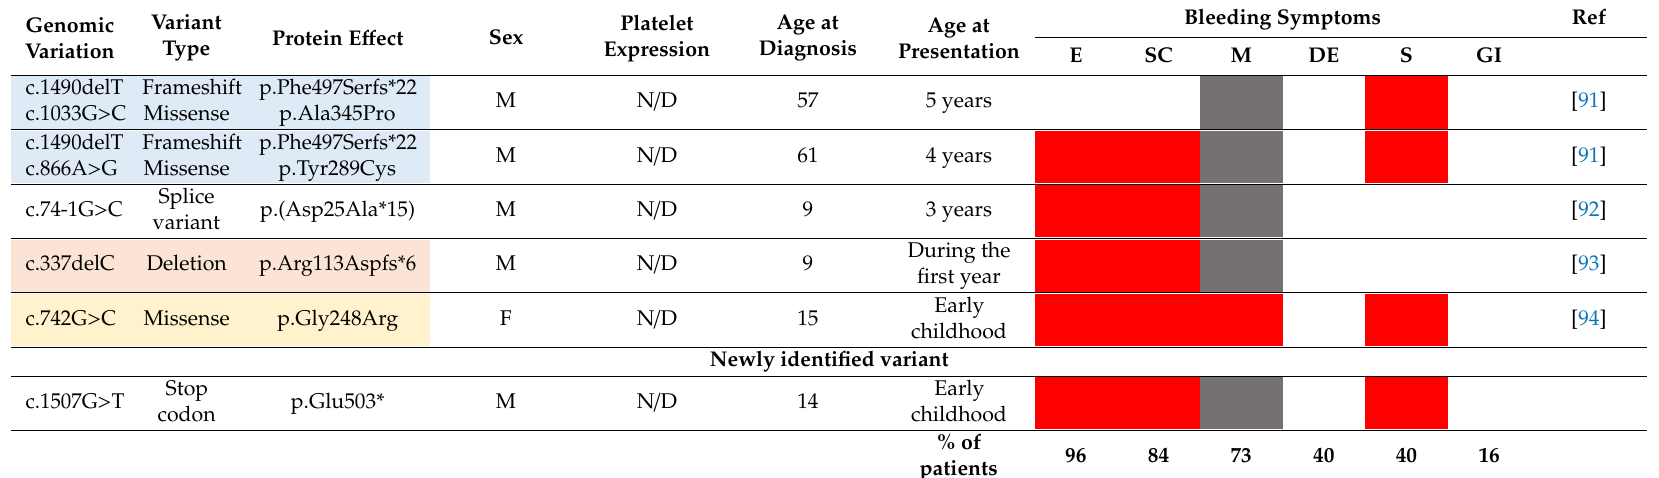
Table 2. Characteristics and bleeding symptoms of the pathogenic RASGRP2 variants reported to